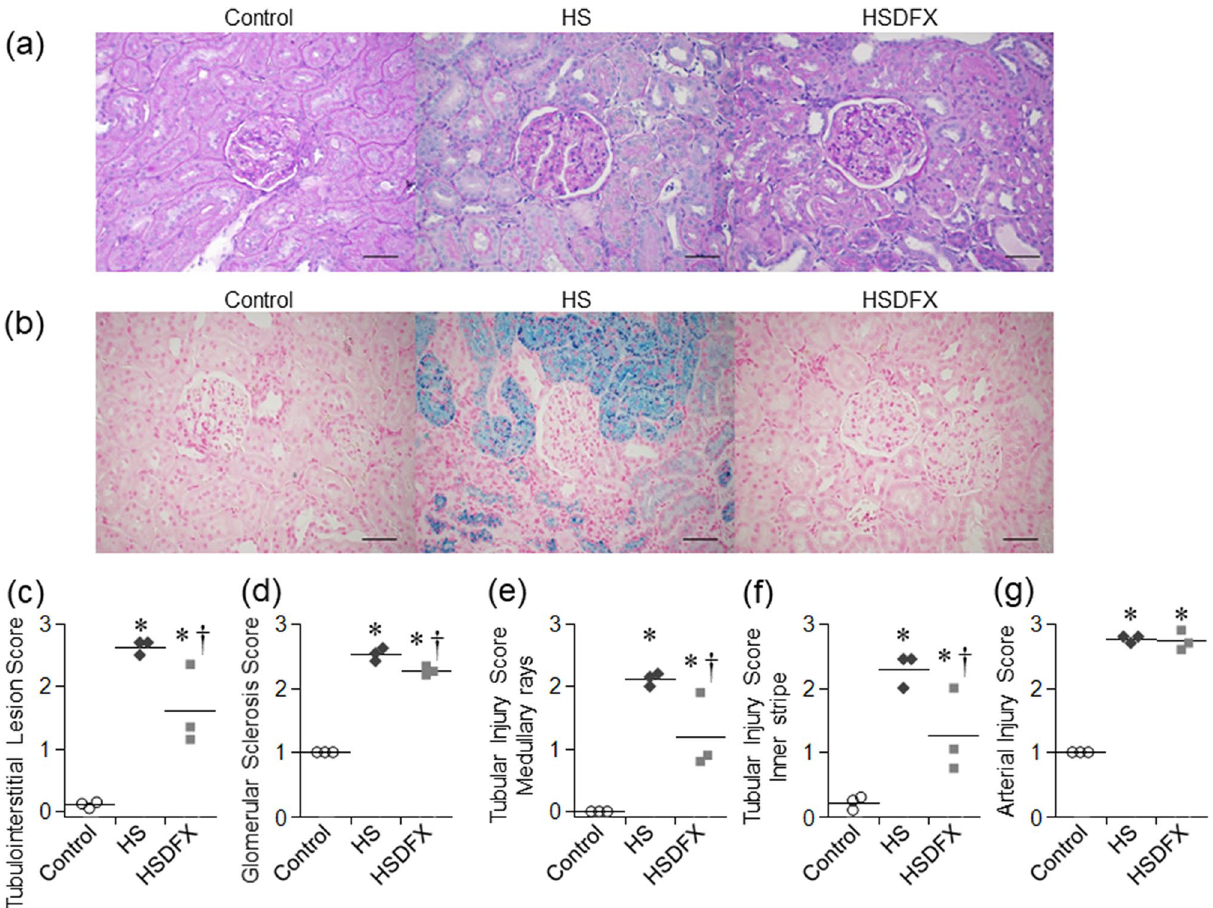
Figure 6. Histological analysis of kidney in Dahl/SS rats. ( a ) Representative PAS staining of the renal cortex in the control, the HS and the HSDFX groups (bars 100 μm). ( b ) Representative Berlin blue staining of the renal cortex in the control, the HS and the HSDFX groups (bars 100 μm). As histological analysis of kidney, tubulointerstitial lesion score ( c ), glomerular sclerosis score ( d ), tubular injury score in the medullary rays ( e ) and the inner stripe ( f ), and arterial injury score ( g ) are shown. Statistical analysis was performed using one- way analysis of variance followed by Tukey–Kramer test in ( c ), ( d ), ( e ), ( f ), and ( g ) by JMP Pro Version 14.2.0 software (SAS Institute Inc.). * p < 0.05 vs. the control group, † p < 0.05 vs. the HS